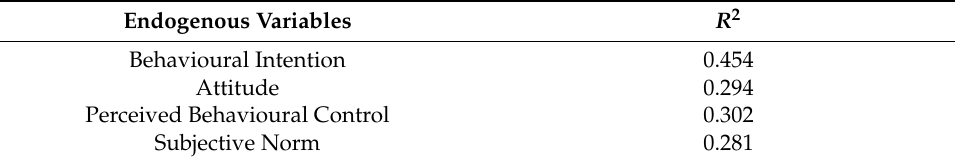
Table 3. Coefficient of determination ( R 2